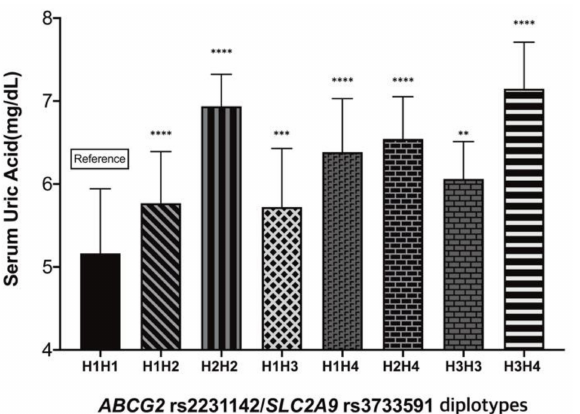
Figure 3. Comparisons between serum uric acid levels according to diplotype of ABCG2 rs2231142 and SLC2A9 rs3733591 polymorphisms. (**, p < 0.01; ***, p < 0.001; ****, p < 0.0001). The asterisks indicate the statistically different levels of uric acid in each diplotype when compared to the H1H1 diplotype (wild